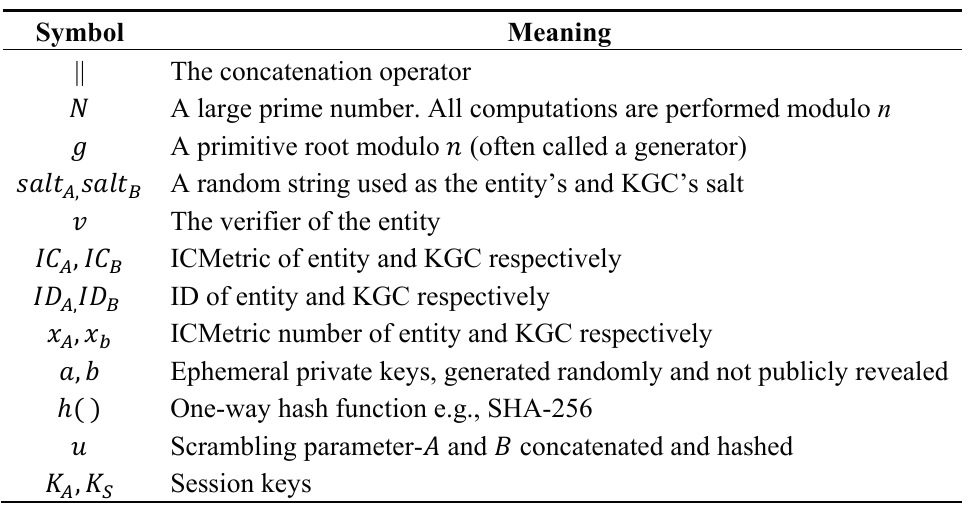
Table 3. Mathematical